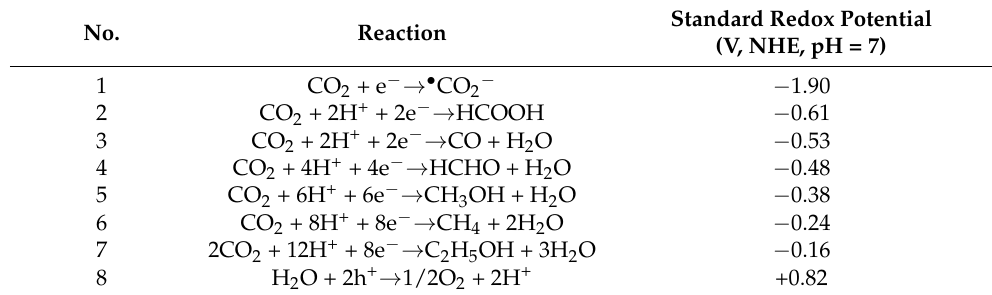
Table 1. Standard redox potentials for photocatalytic CO 2 reduction to different products [47].